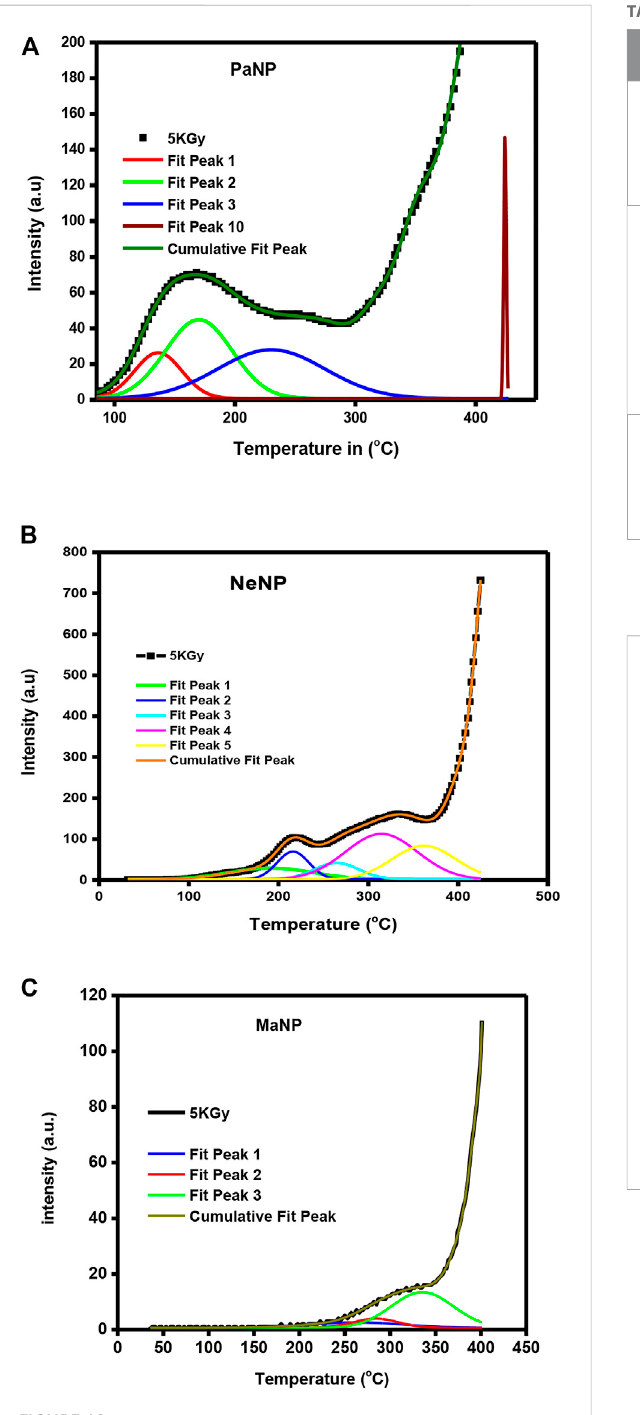
FIGURE 10 Deconvoluted glow peaks of (A) PaNP; (B) NeNP and (C) MaNP.